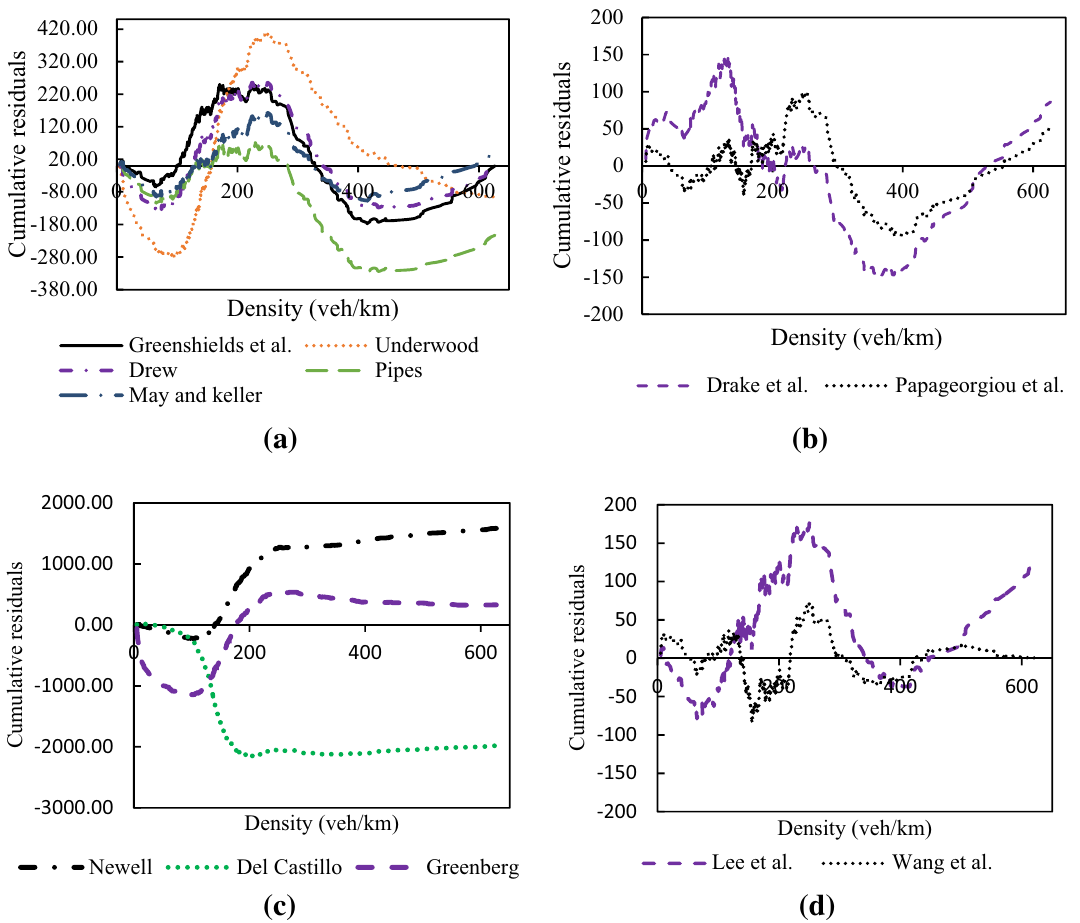
Fig. 7 CURE plots for a linear models, b Drake et al. and Papageorgiou et al.’s models, c Newell, Del Castillo and Greenberg’s models, d Lee et al. and Wang et al.’s models